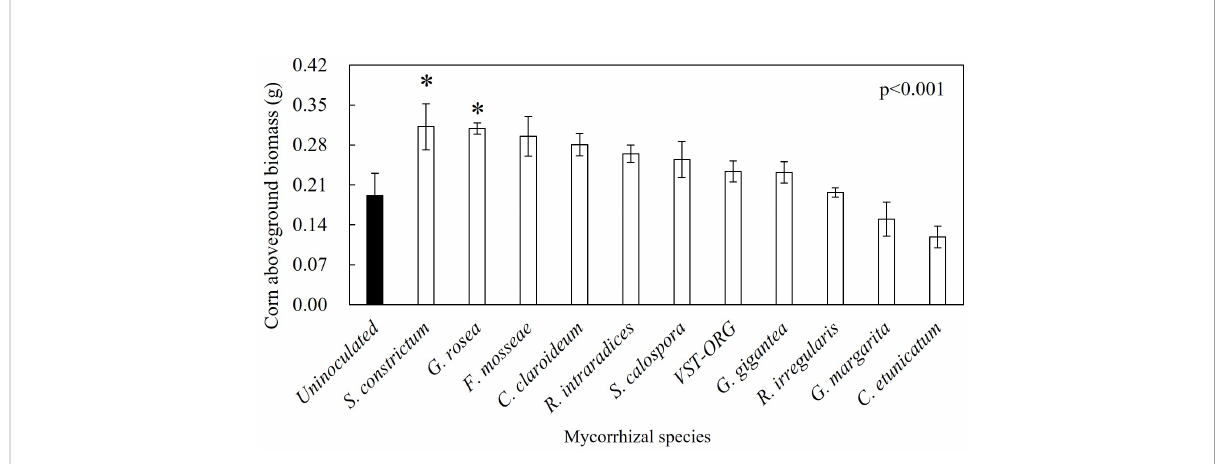
FIGURE 5 S. constrictum and G. rosea enhanced corn seedling aboveground biomass 30 days post germination. The closed bars are uninoculated seedlings and the open bars are inoculated seedlings. P values are from one-way ANOVA. Asterisks represent signi fi cant differences between uninoculated seedlings and inoculated seedlings.